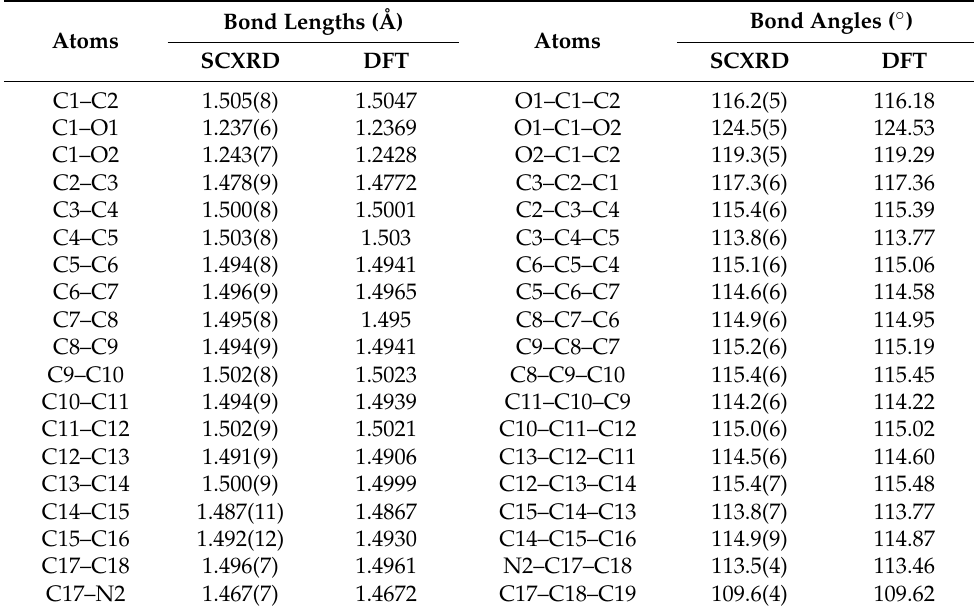
Table 2. Bond lengths (Å) and angles ( ◦ ) for